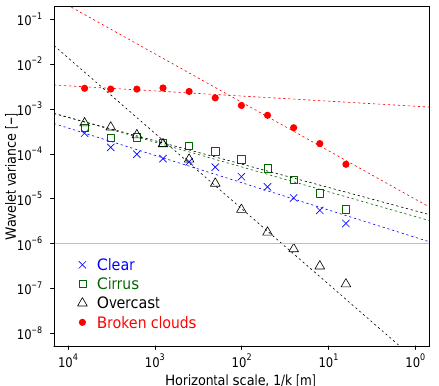
Figure 5. Wavelet variance of global transmittance (as shown in Fig. 4a) represented as a function of horizontal scales denoted by 1 /k (in m) for different sky conditions during the HOPE campaign. Dashed lines represent the least-square fits at different scale regimes using Eq. (3). The gray color horizontal line correspond to the mea- surement uncertainty of our